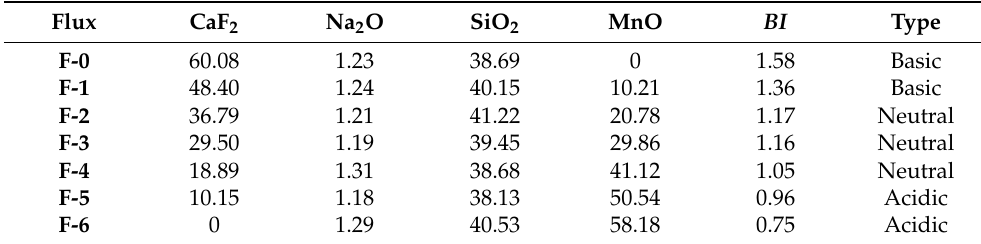
Table 1. Measured compositions of the fluxes (wt pct) [3].